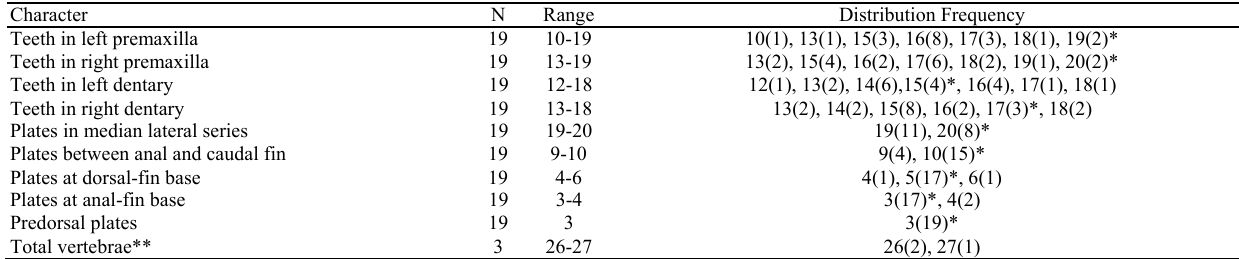
Table 3. Frequency of distribution of meristic data for Otothyropsis piribebuy. Holotype values are marked with an asterisk. Meristic maked with double asterisks was counted in c&s specimens only. N = Number of